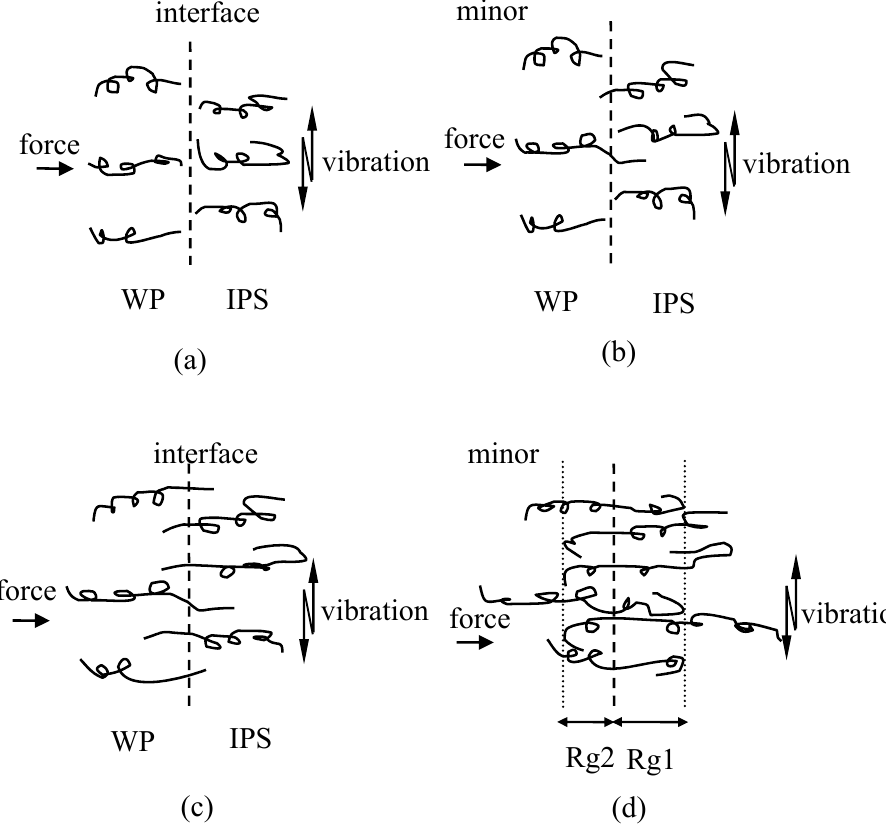
Figure 23. Schematic drawing of macromolecular inter-diffusion of IPS and WPs. Adapted from Reference [147]. Temperatures of the interfaces are ( 1 ) under room temperature; ( 2 ) higher than glass transition temperature; ( 3 ) above melting point; ( 4 ) back to room temperature.